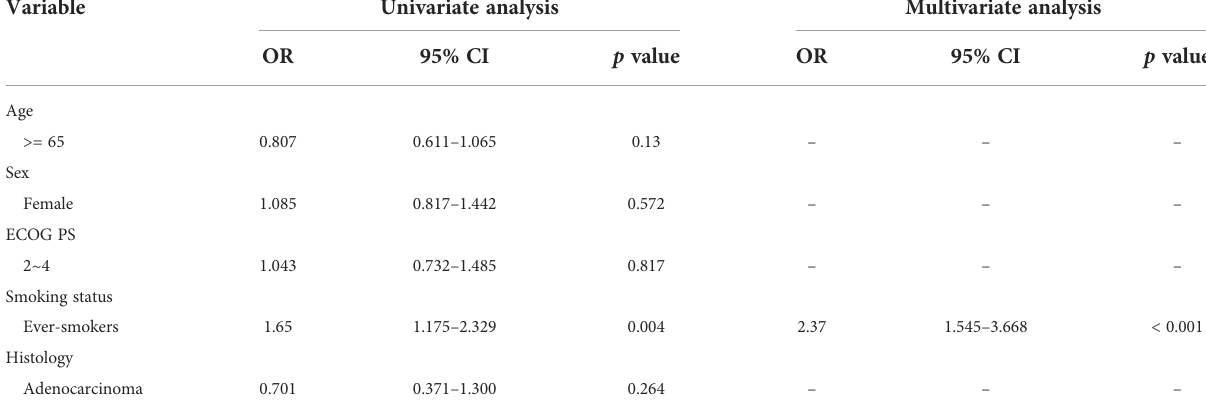
TABLE 2 Logistic regression analysis for association factors of EGFR mutation status.